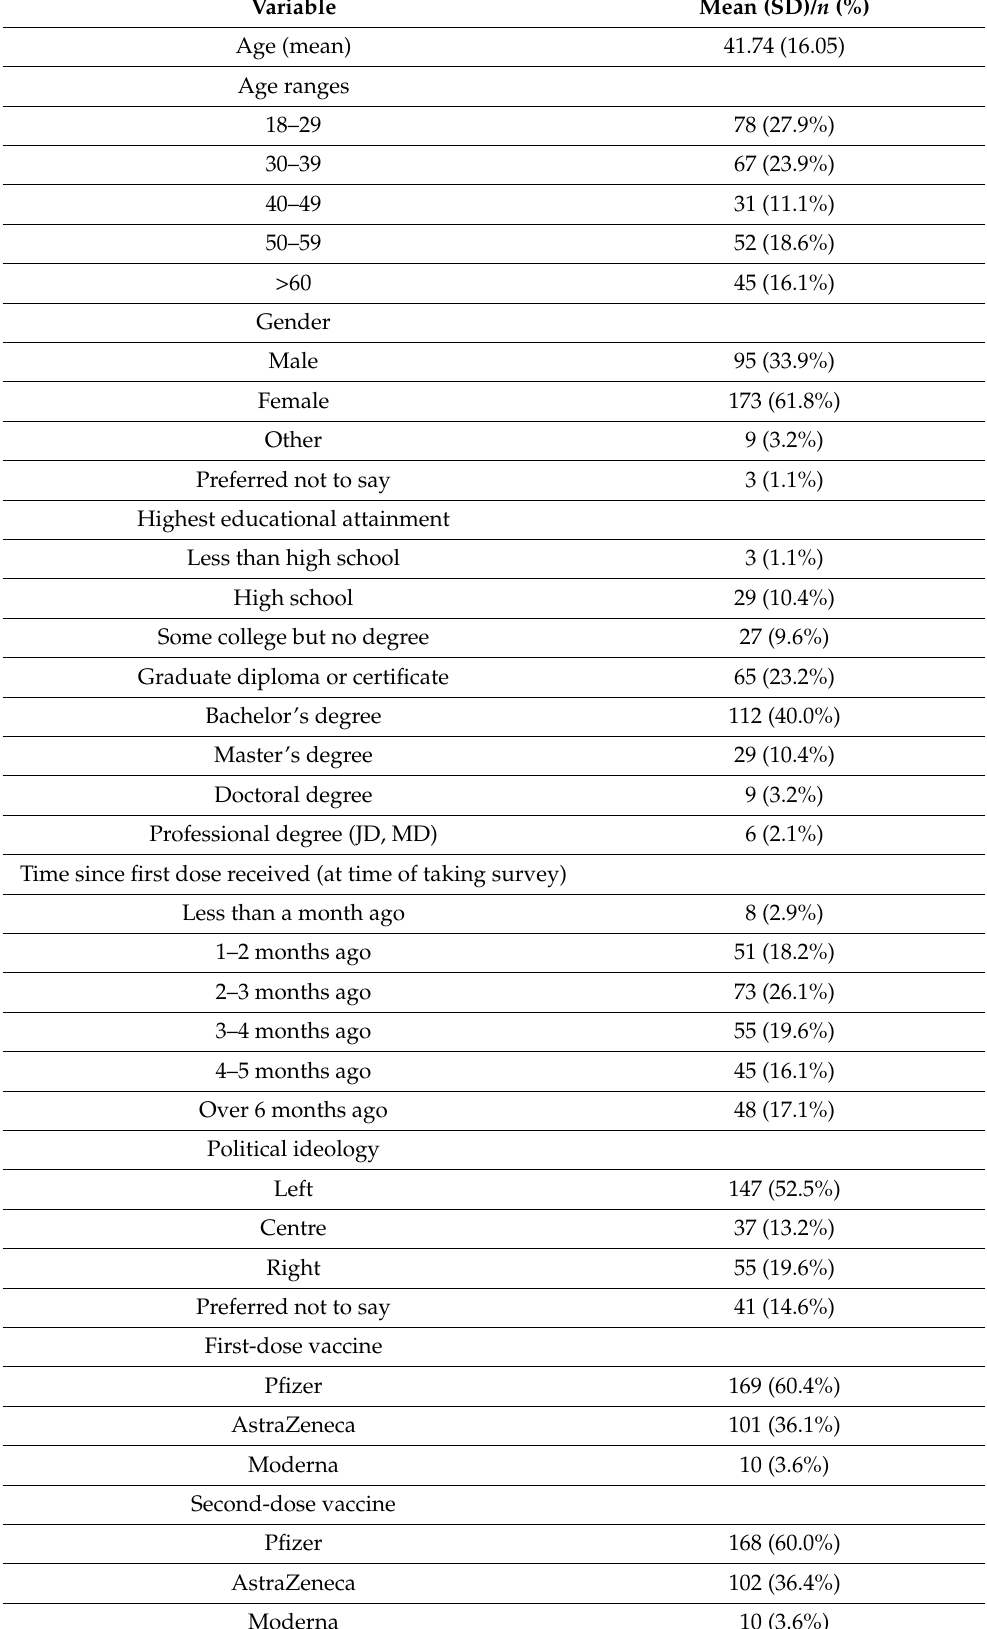
Table 1. Demographic